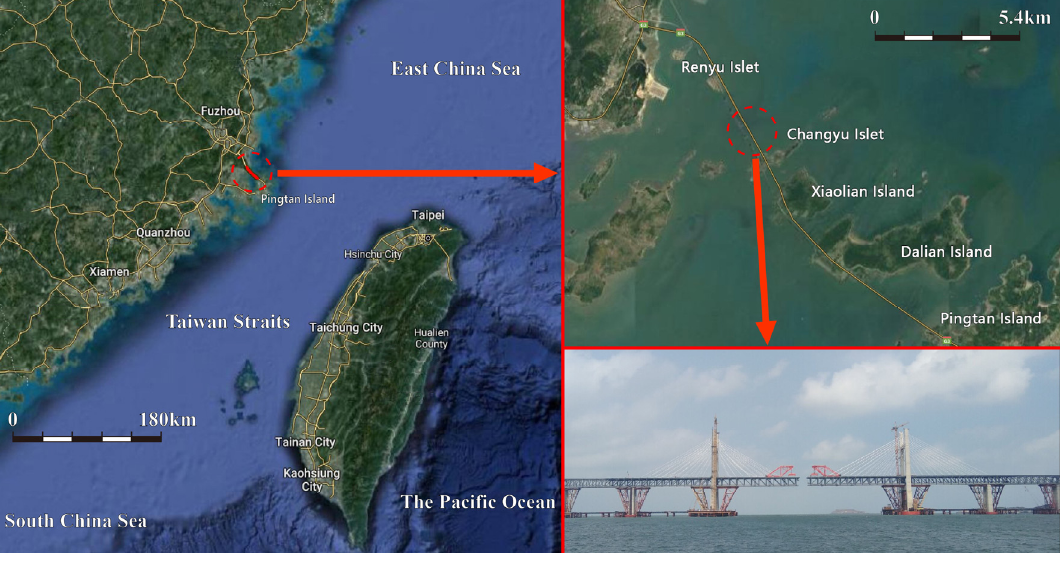
Figure 1. Bridge and its location.